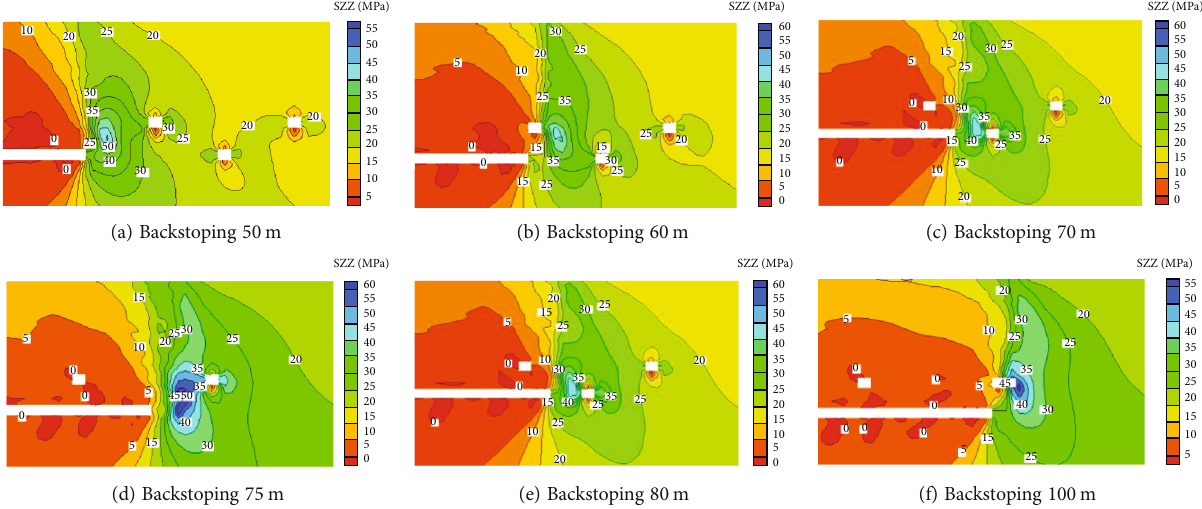
Figure 9: Stress distribution at di ff erent positions when the working face passes through the abandoned roadways.